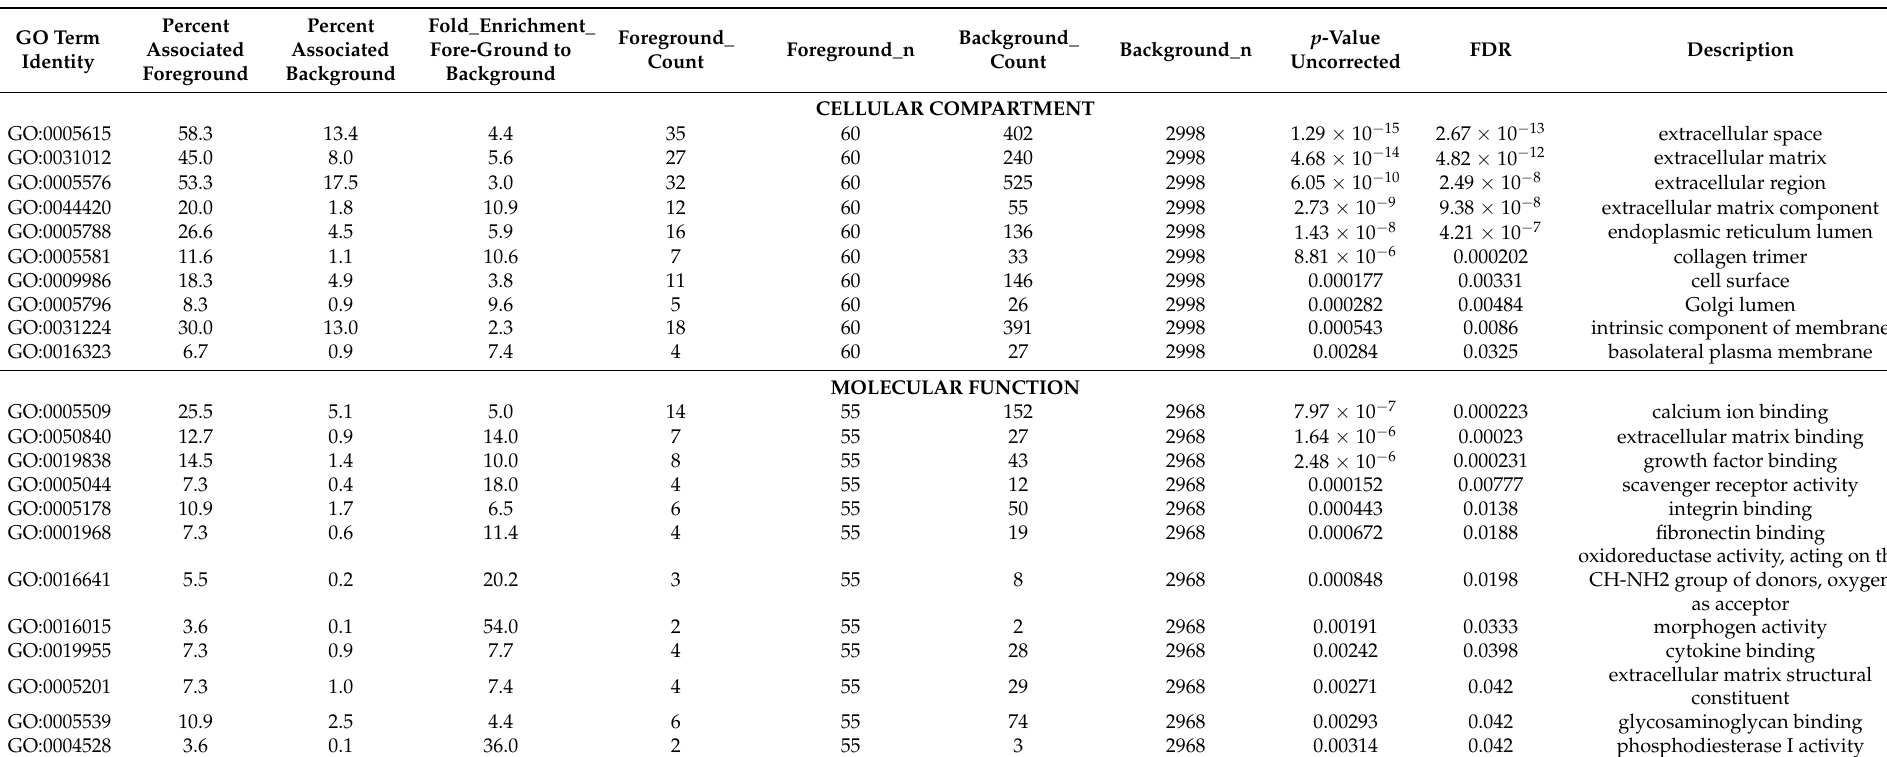
Table 5. GO term analyses of the 60 proteins released by a minority of patient samples ( ≤ 10) when AML cells were cultured alone but detected for most patient samples ( ≥ 30) when MSCs were cultured with AML-conditioned medium (AML-CM). The table presents the significant GO terms (FDR < 0.05) when analyzing Cellular compartments and Molecular